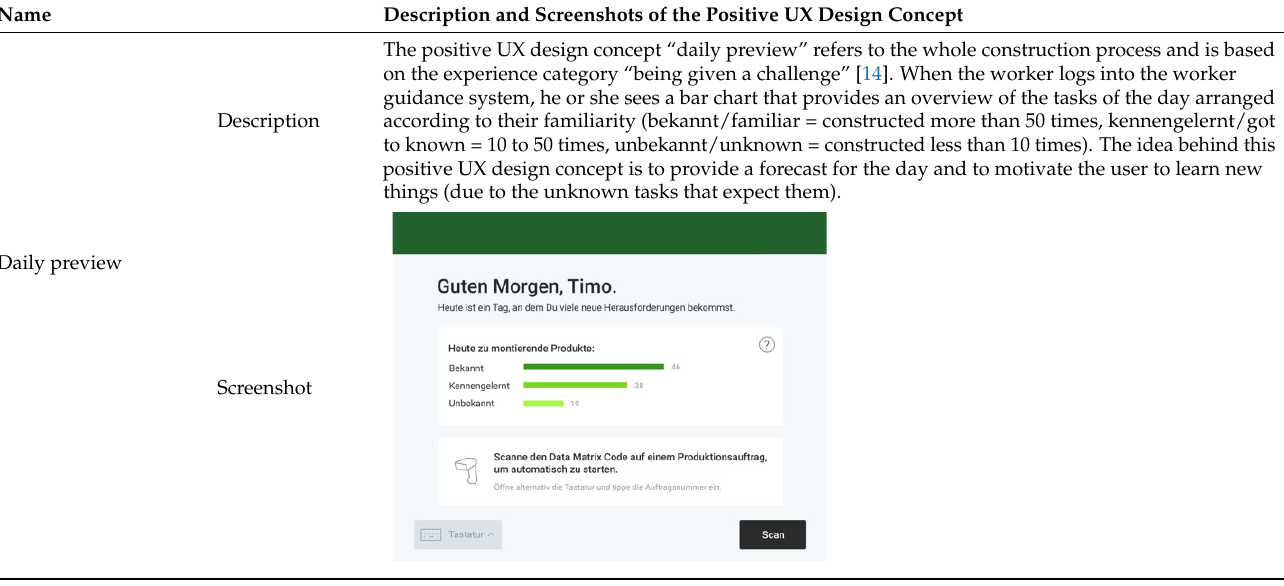
Table 2. Positive user experience (UX) design concepts for worker guidance system